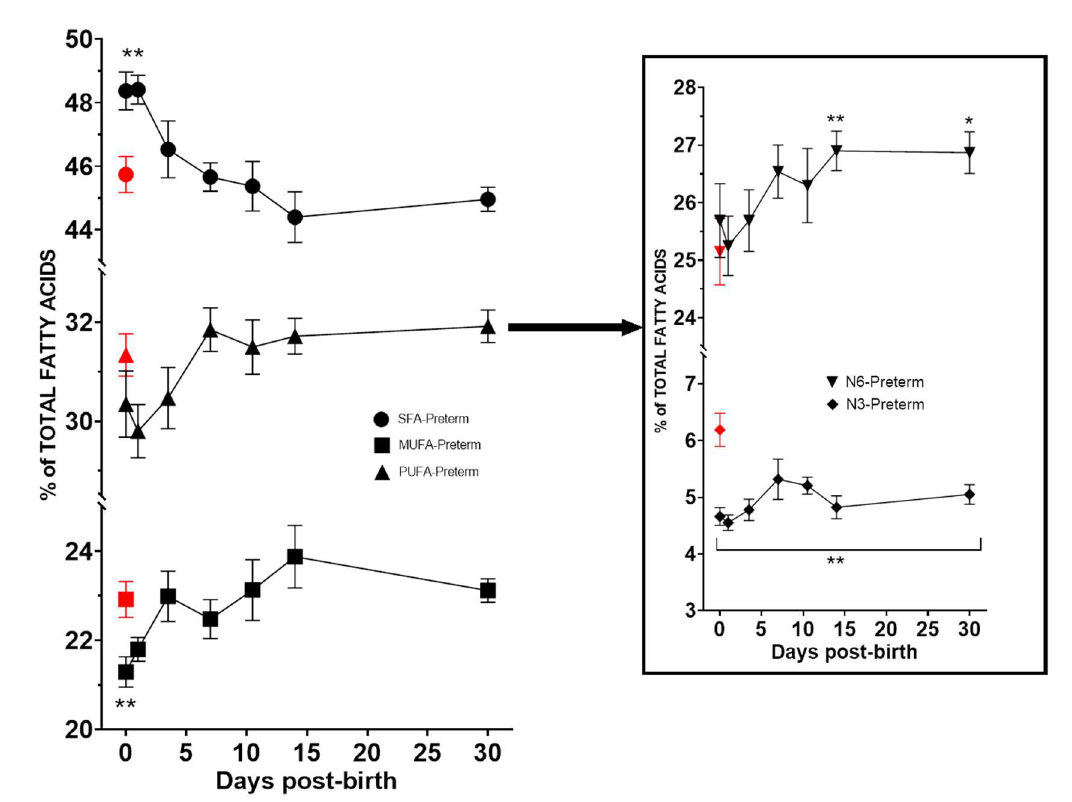
Figure 1. Evolution of the main fatty acid families in preterm neonates during the first 30 days of life as compared with values at birth on neonates at term (red symbol) (asterisks indicate statistically significant differences, p < 0.05, * p < 0.05, ** p < 0.001).